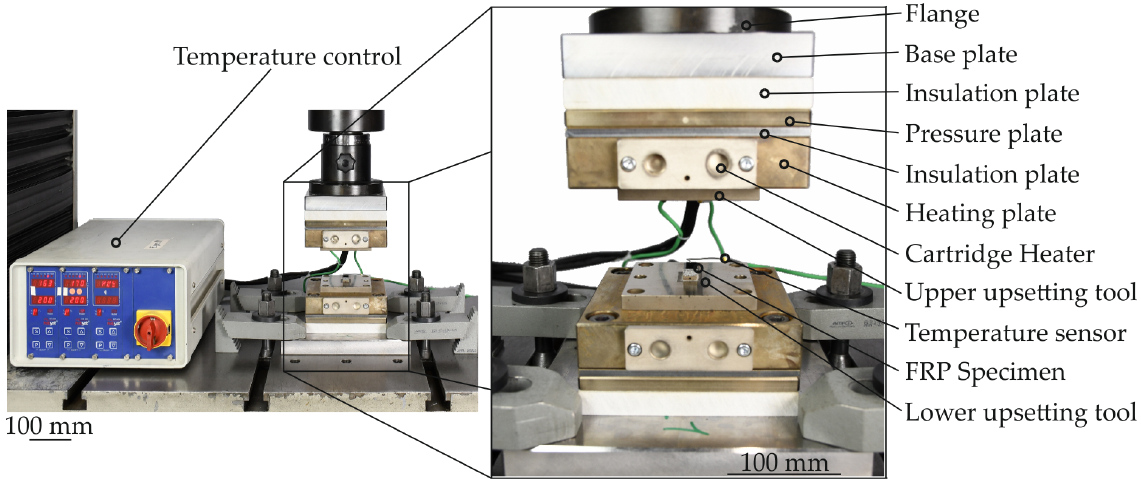
Figure 6. Experimental setup of the flat crush